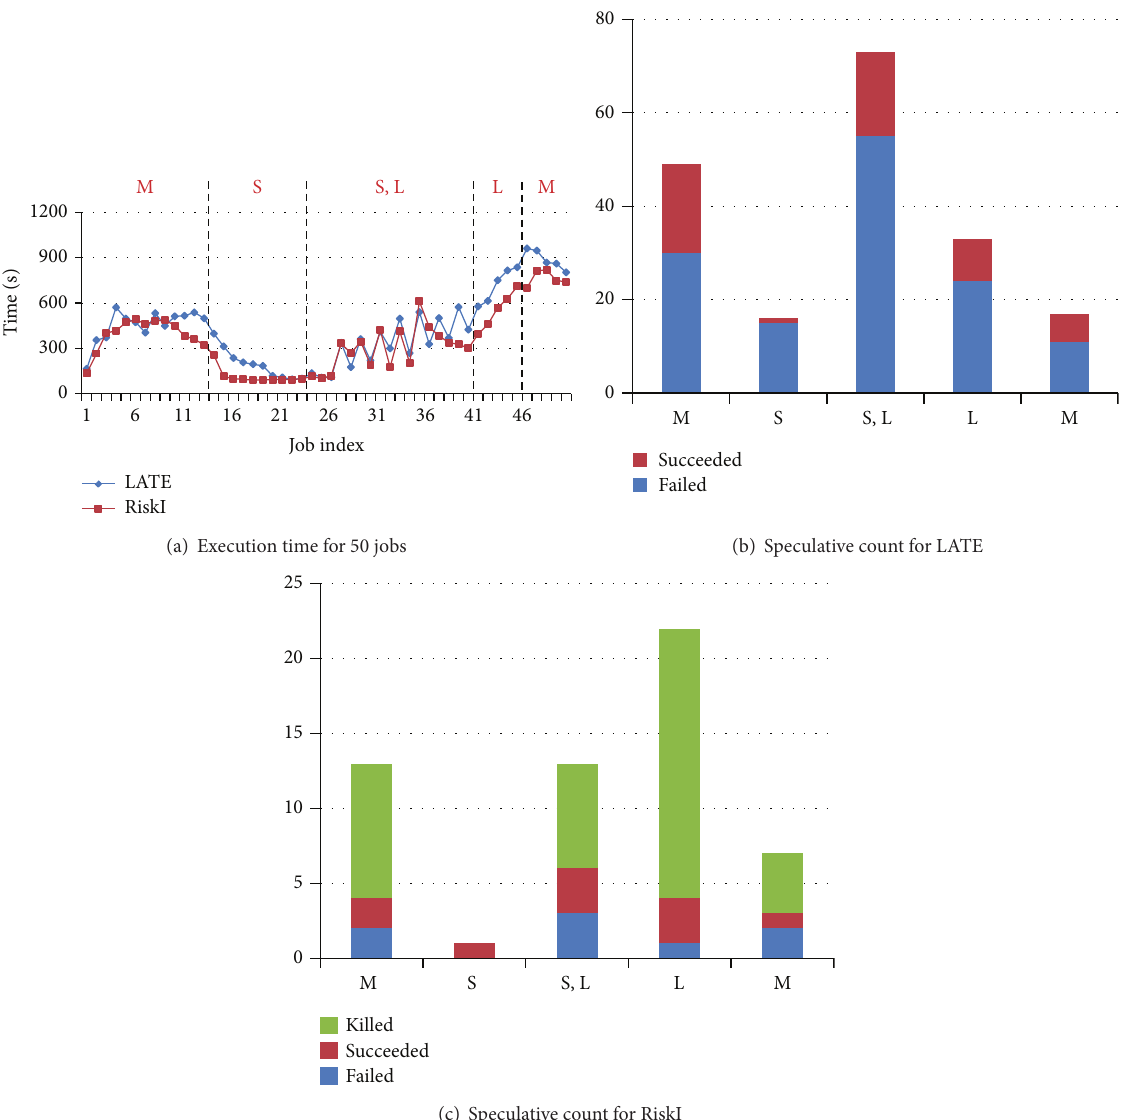
Figure 12: Details of execution information with interval 60. (a) is static of execution time for each job. (b and c) are statistics of speculative execution count in different